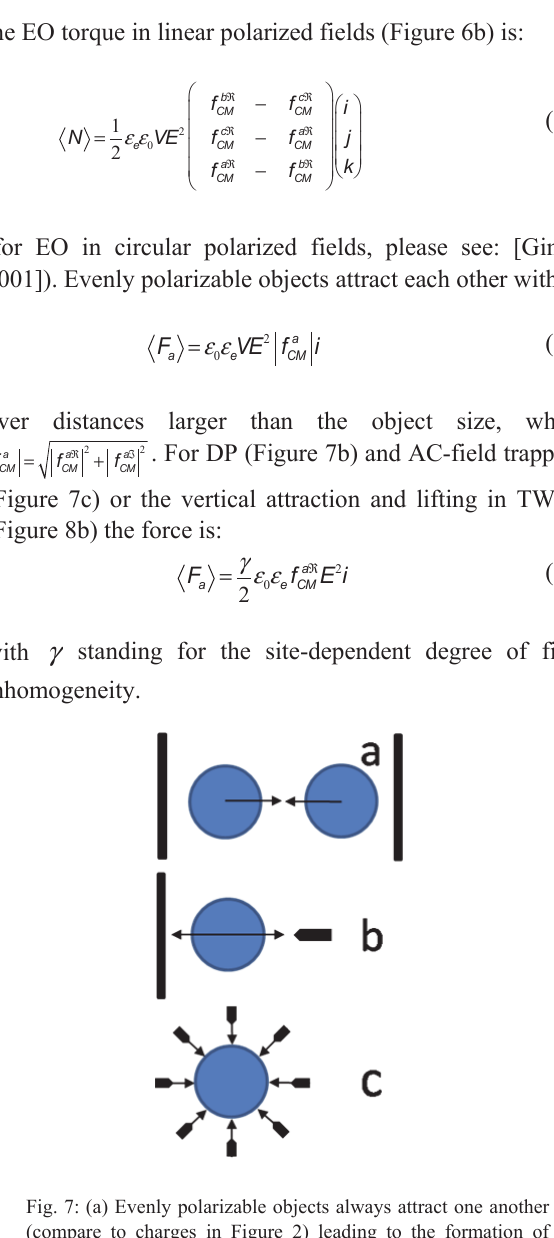
Fig. 6: (a) ED according to Figure 2. (b) For three-axial, ellipsoidal objects each axis may be oriented in parallel to the field. Orientation depends on field frequency, object and medium properties. The field electrodes as well as the possible (frequency-dependent) forces and torques are marked by bold dark lines and arrows, respectively.